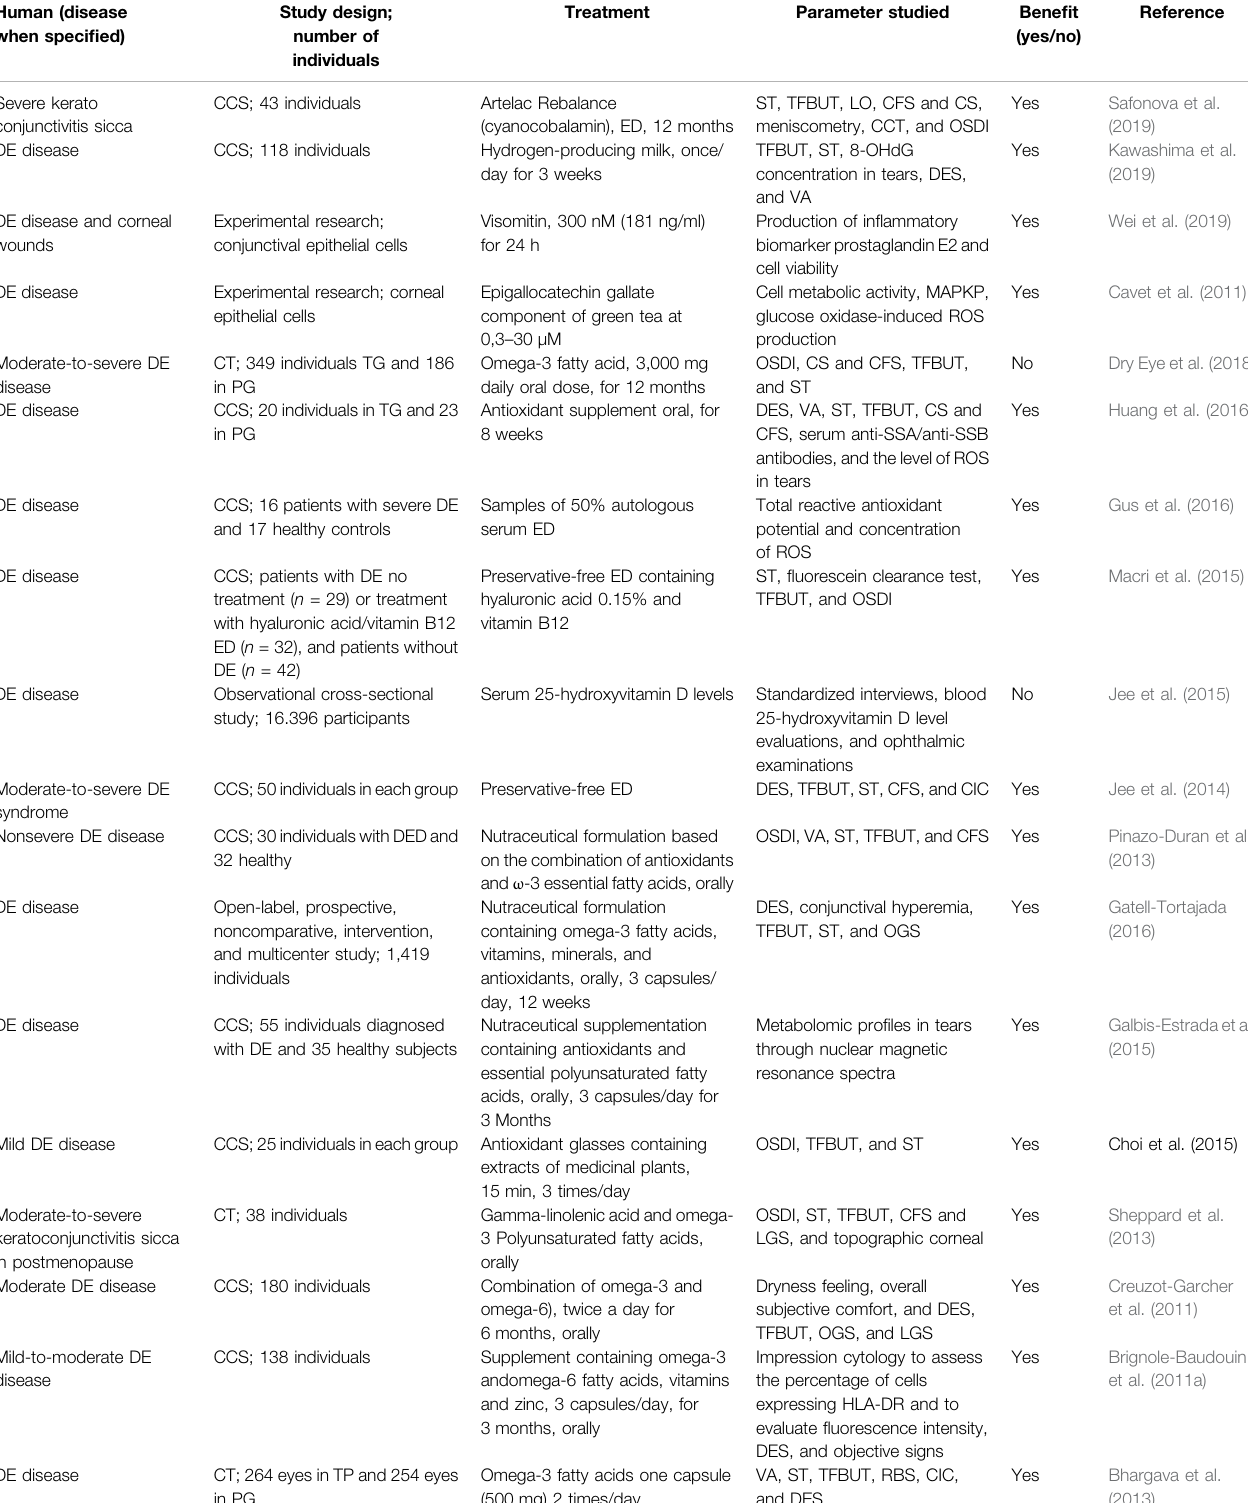
TABLE 5 | Preventive and therapeutic antioxidant strategies for DE disease in humans published between 2010 and 2019 were searched for “ antioxidant ” and “ dry eye ” in PubMed. Human (disease when speci fi